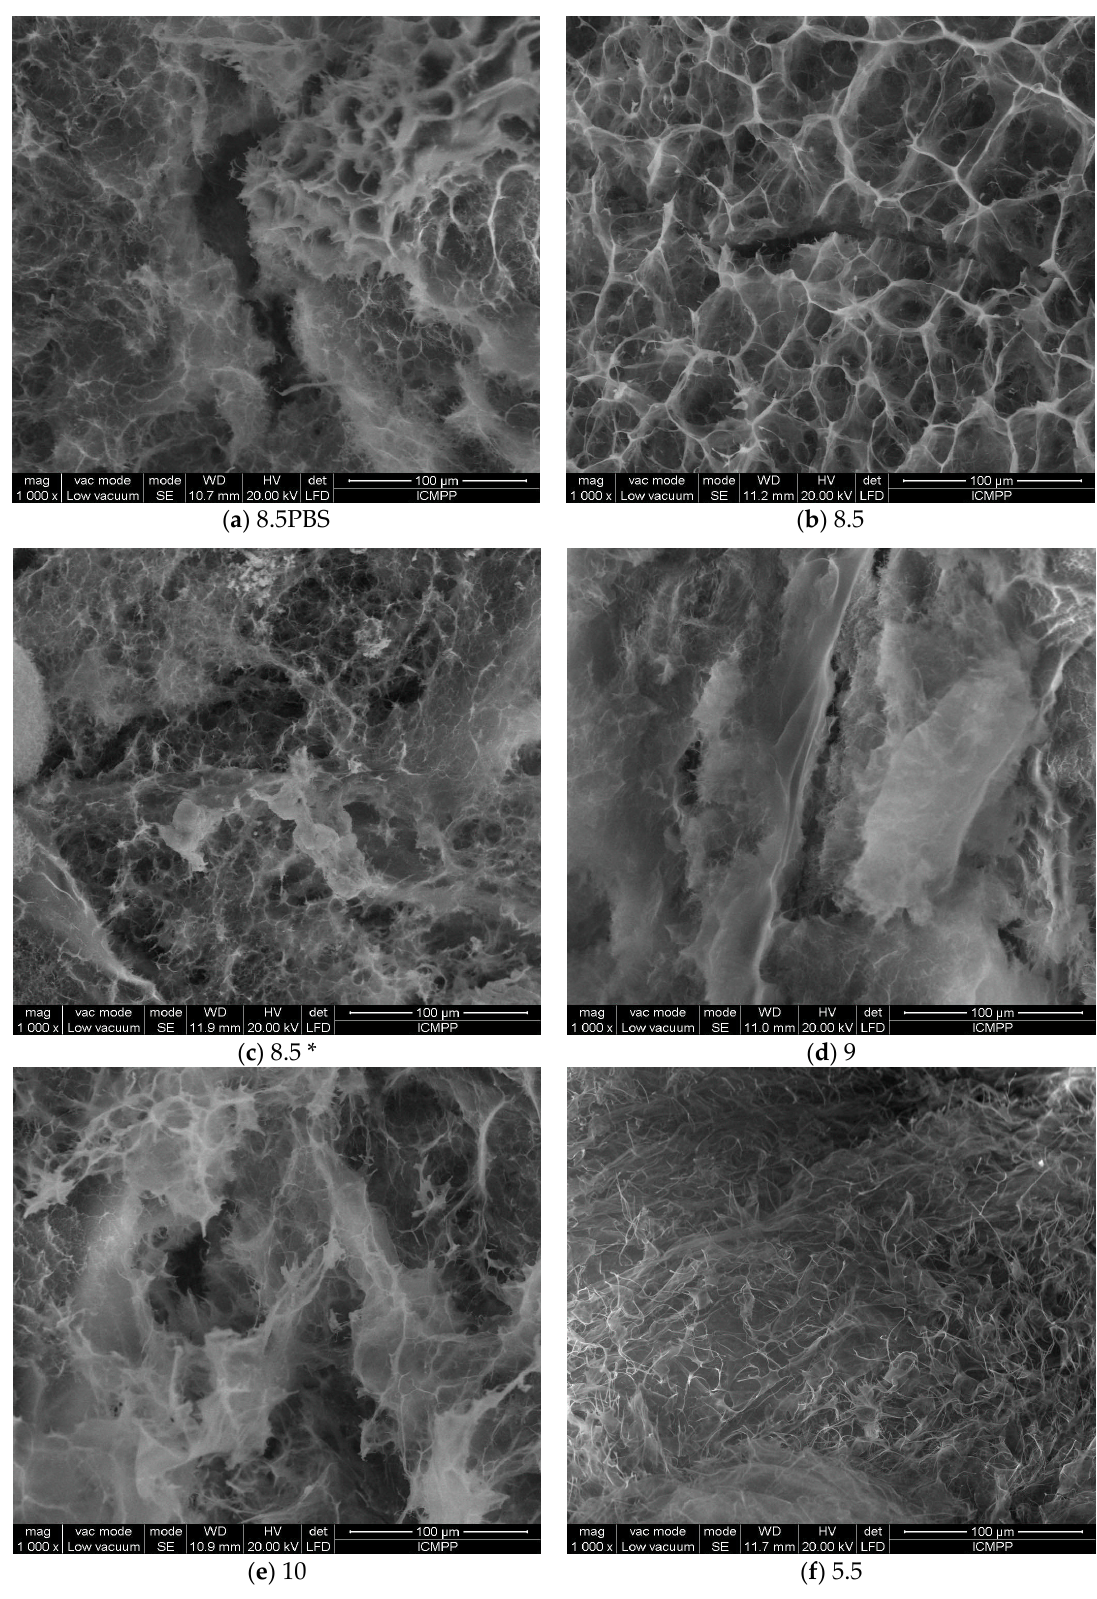
Figure 7. The morphology of the hydrogel after the enzymatic biodegradation over 14 days at different pH ( a – e ) and after the first day of biodegradation in medium of pH = 5.5 ( f ). (* indicates a lysozyme concentration of 4830 U/mL; 8.5PBS indicates the absence of lysozyme) In PBS, without enzyme, the pores of hydrogel appeared collapsed, and ruptures oc- curred, in line with the release of the aldehyde and partial dissolution of the chitosan. Interestingly, no such effect was observed at pH = 8.5 in the presence of a lysozyme con- centration characteristic to the non-infected wounds in the first minutes after wound oc- currence; the morphology appeared less affected. On the other hand, at pH = 9.5 and 10, characteristic to a wound exudate over the healing period of the first four days, which is determinant for the evolution of wound to a complete recovery of tissue, the hydrogel showed a loose morphology, in agreement with the massive mass loss. Furthermore, at pH = 5.5, characteristic for the normal dermis, massive biodegradation was evident, with the hydrogel morphology transforming into a fibrous one, suitable for tissue regeneration. 3.4. Application Results of Fractal and Lacunar Analysis Algorithms Fractal geometry is the mathematical completion that Euclidean geometry and crys- talline (or quasi-crystalline) symmetry were lacking. Fractal analysis, which is the main vein/lode exploited with this new way of thinking, works with two basic notions, namely, fractal size and lacunarity.